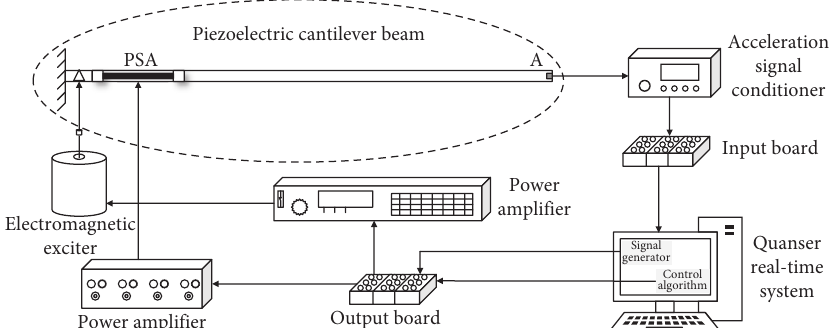
Figure 8: AVC experimental diagram of the piezoelectric cantilever beam.